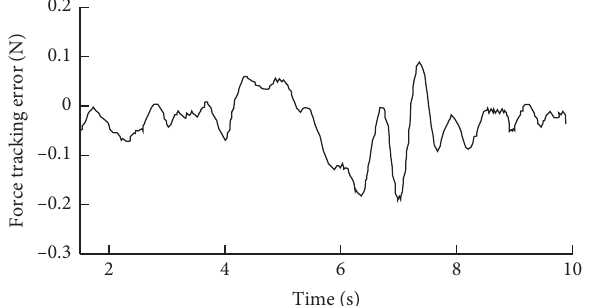
Figure 8: The constant force tracking initialization parameters are determined as η � 0 . 25 and α � 0 . 04. The initial value of the weight vector, the node center, and the width value of the basis function are shown as follows: